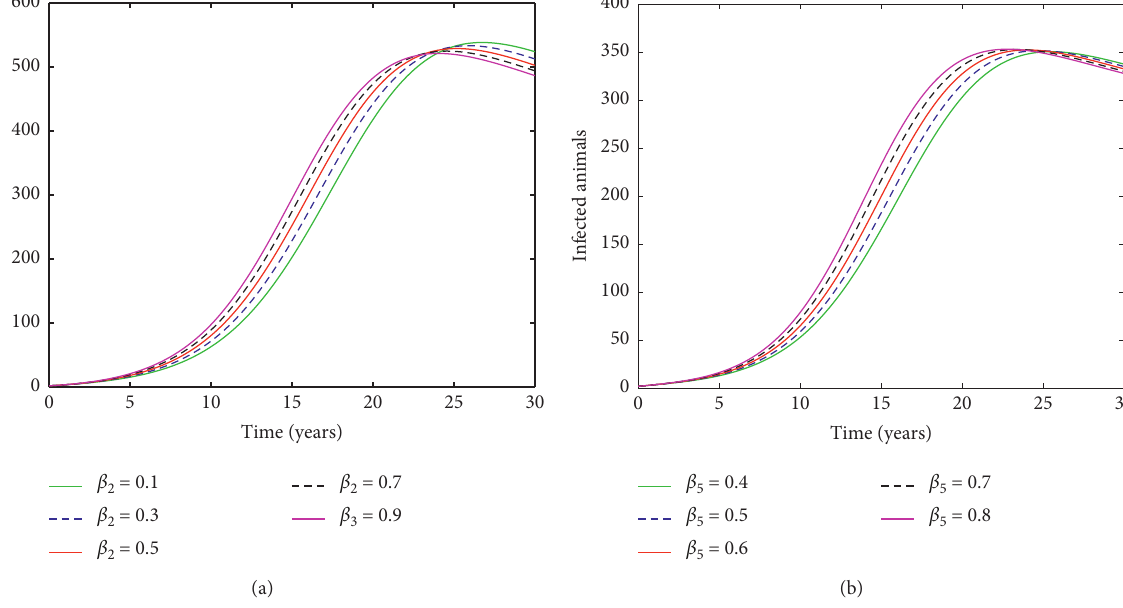
Figure 6: Variation of humans and animals infection rates from infectious animals to infectious human and animals classes, respectively. (a) Infected humans. (b) Infected